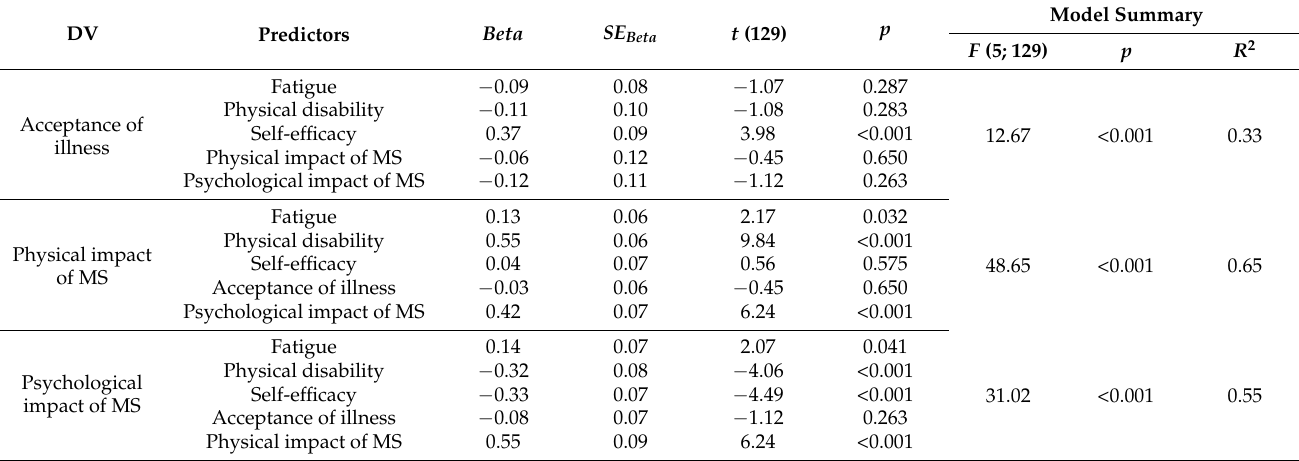
Table 5. Results of three separate multiple regression